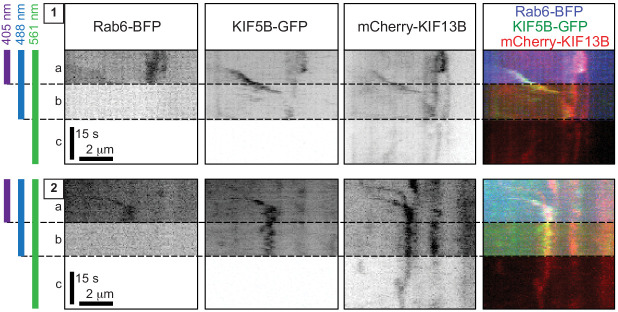
Validation of simultaneous three-color image acquisition.Live TIRF imaging of 4X-KO cells co-expressing TagBFP-Rab6, full-length KIF5B-GFP and full-length mCherry-KIF13B. Kymographs of two different vesicles (1 and 2) from two different cells simultaneously imaged with 405 nm, 488 nm and 561 nm lasers are shown. Simultaneous three-color imaging shows that the vesicles are co-labeled with the three fluorescently tagged proteins (section (a) of each kymograph). As blue fluorescence can potentially be detected in the green channel, we confirmed that switching off the 405 nm laser (b) did not have a major impact on the green channel signal (meaning that the initial green signal was not caused by cross-talk with the blue channel). Turning off the 488 nm laser (c) also did not have a major impact on the red channel. These controls show that there is no significant crosstalk between channels in our microscope setup, and that we can reliably simultaneously detect blue, green and red channels on moving vesicles.